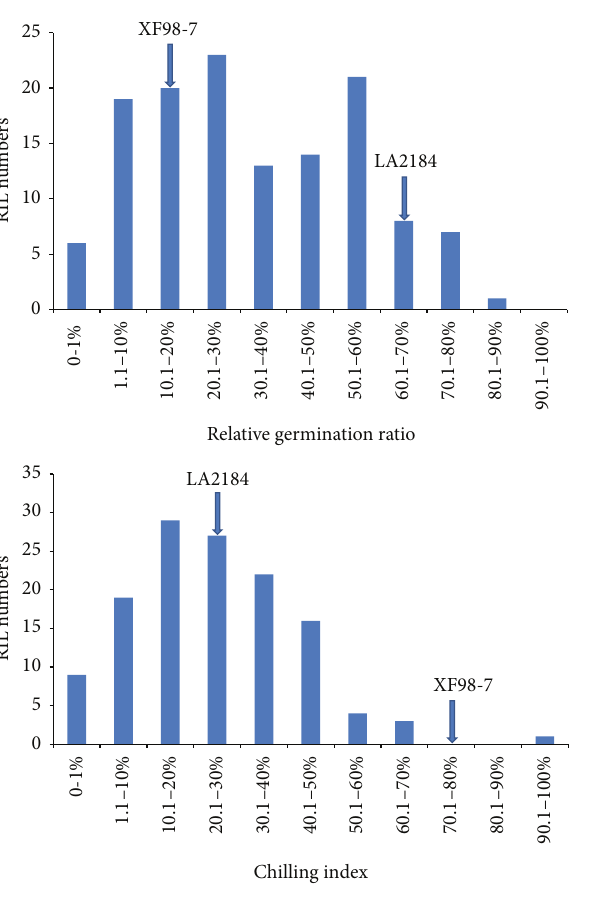
Figure 1: Frequency distribution of relative germination ratio and chilling index associated with cold tolerance in parental lines and RIL